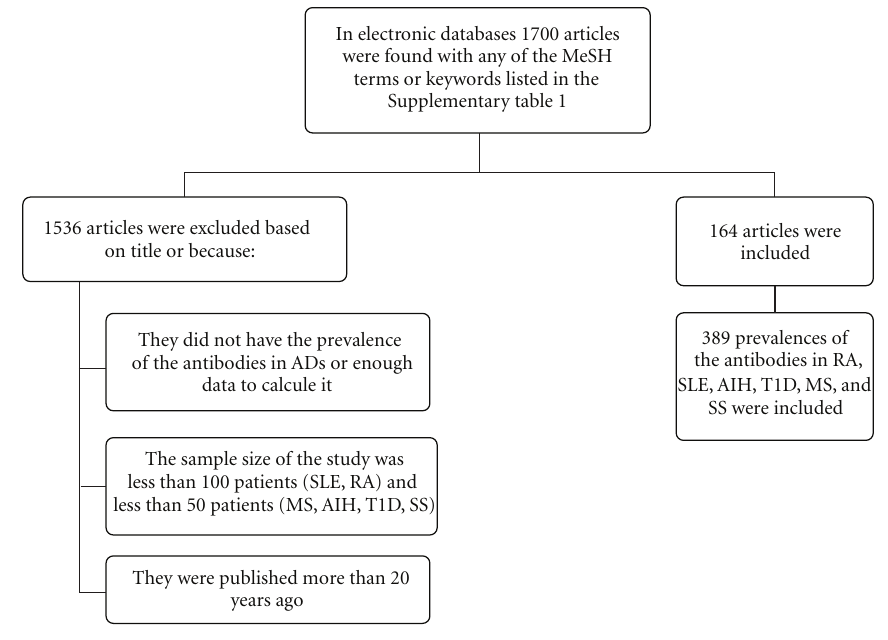
Figure 1: Flow chart of the systematic literature